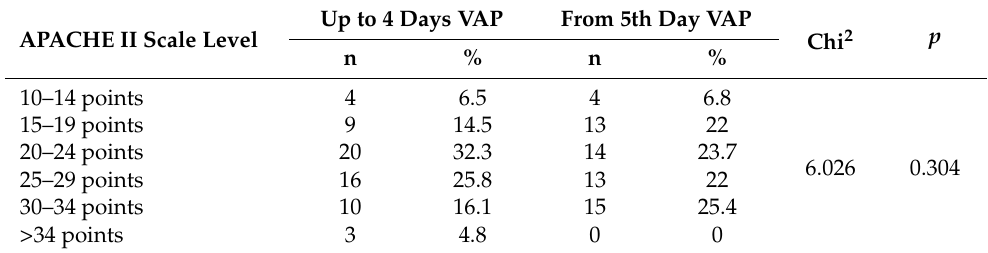
p value for the chi 2 test—level of statistical significance.